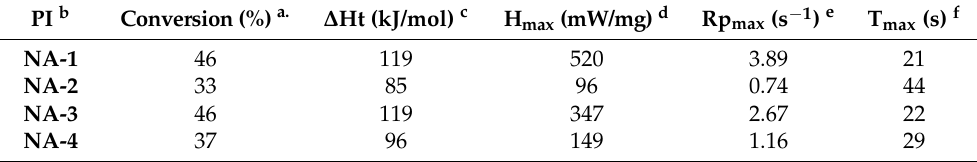
Table 2. Photo-DSC results based on UV light irradiation.